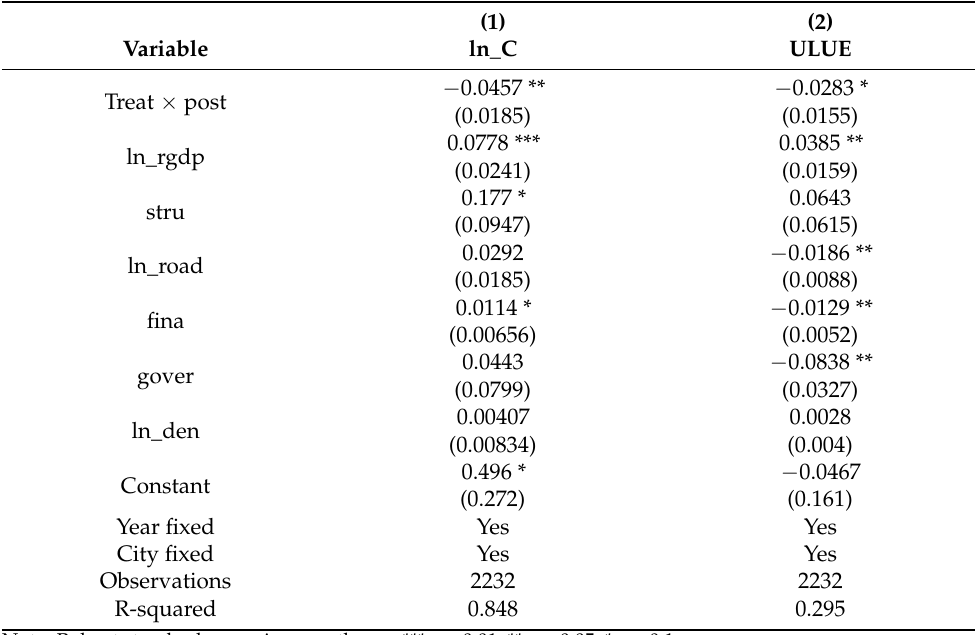
Table 4. Results of the two estimations for the effects on CO 2 and